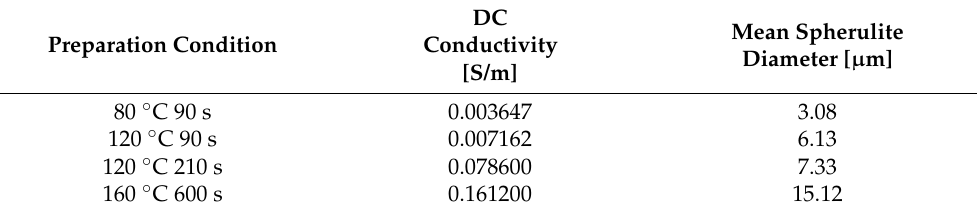
Table 1. Direct current conductivity and spherulite diameter of solid polymer electrolyte based on [EMIM][TFSI] ionic liquid, PVDF as polymer matrix and NMP as a solvent and prepared under different